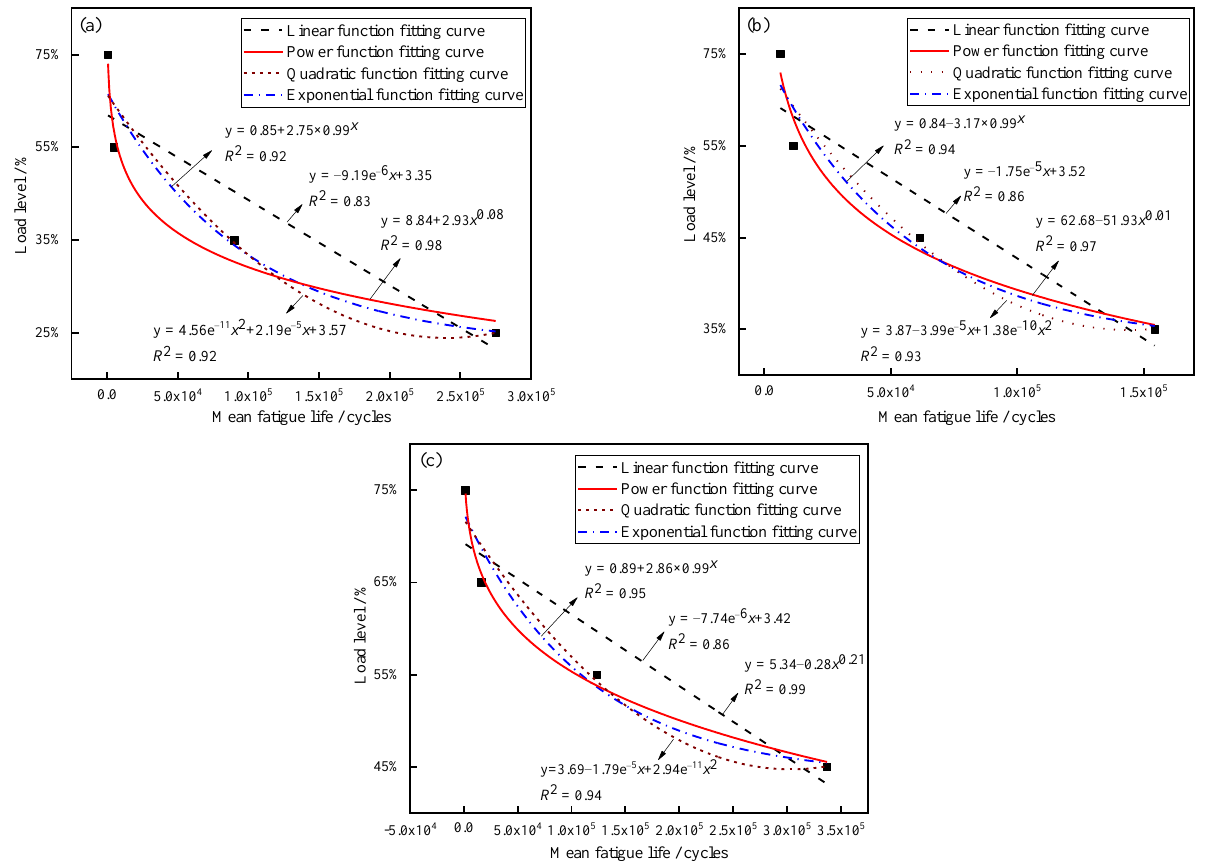
Figure 7. Typical SN curves of the joints: ( a ) [0/90] 4s , ( b ) [0/45/ − 45/90] 2s , and ( c ) [45/ − 45] 4s.